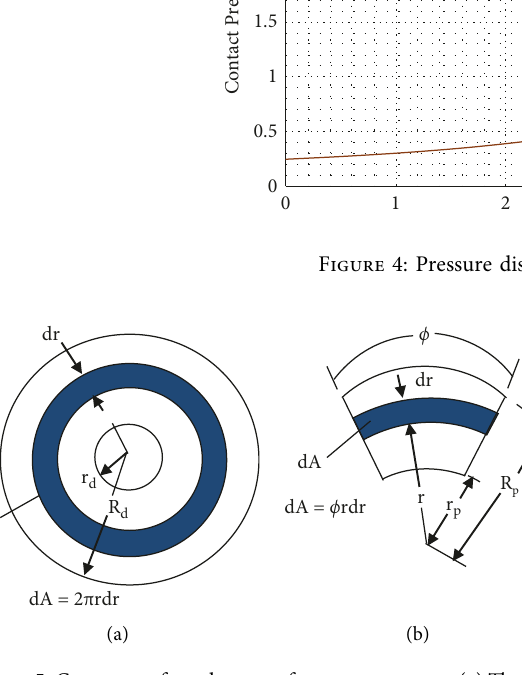
Figure 5: Contact surface element of two components. (a) The disk and (b) the